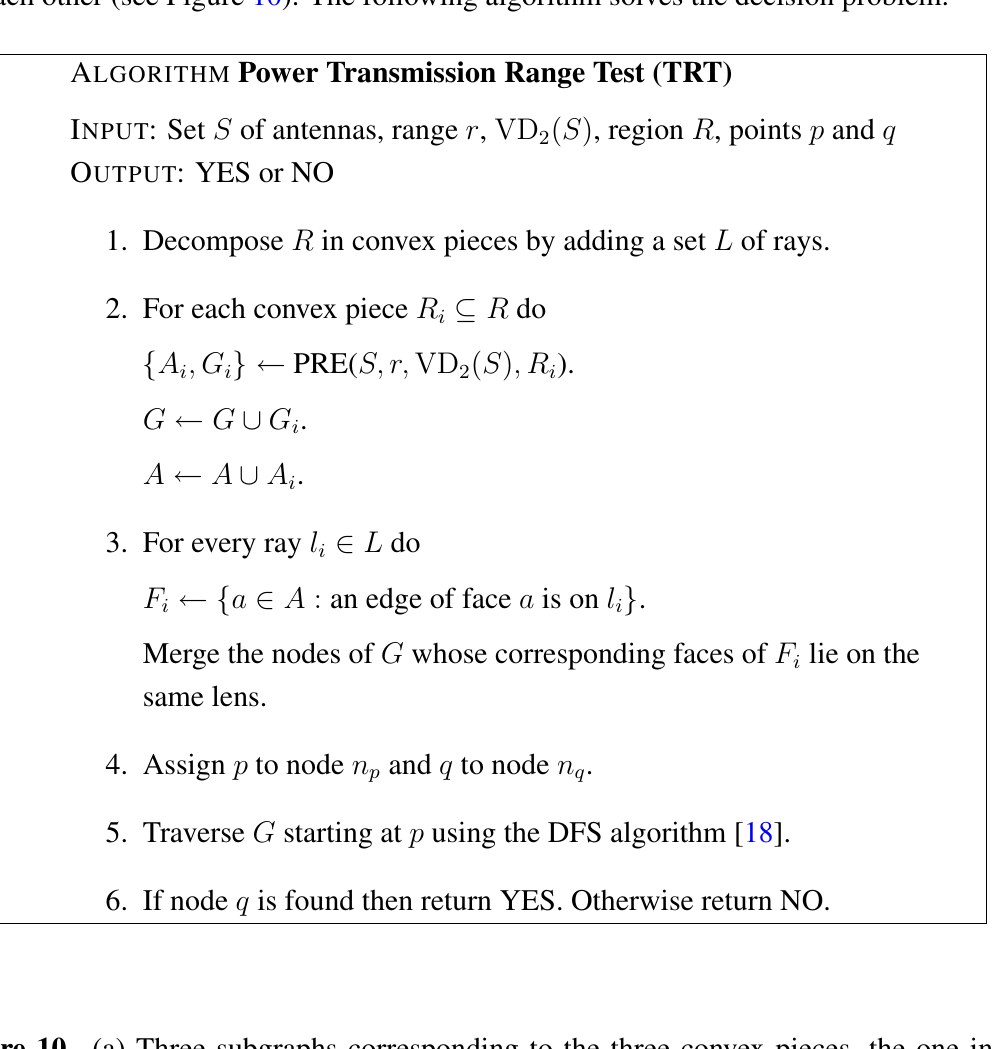
Figure 10. (a) Three subgraphs corresponding to the three convex pieces, the one in the green region is disconnected. (b) There is not a 2 -path between p and q because they lie in different connected components of the complete